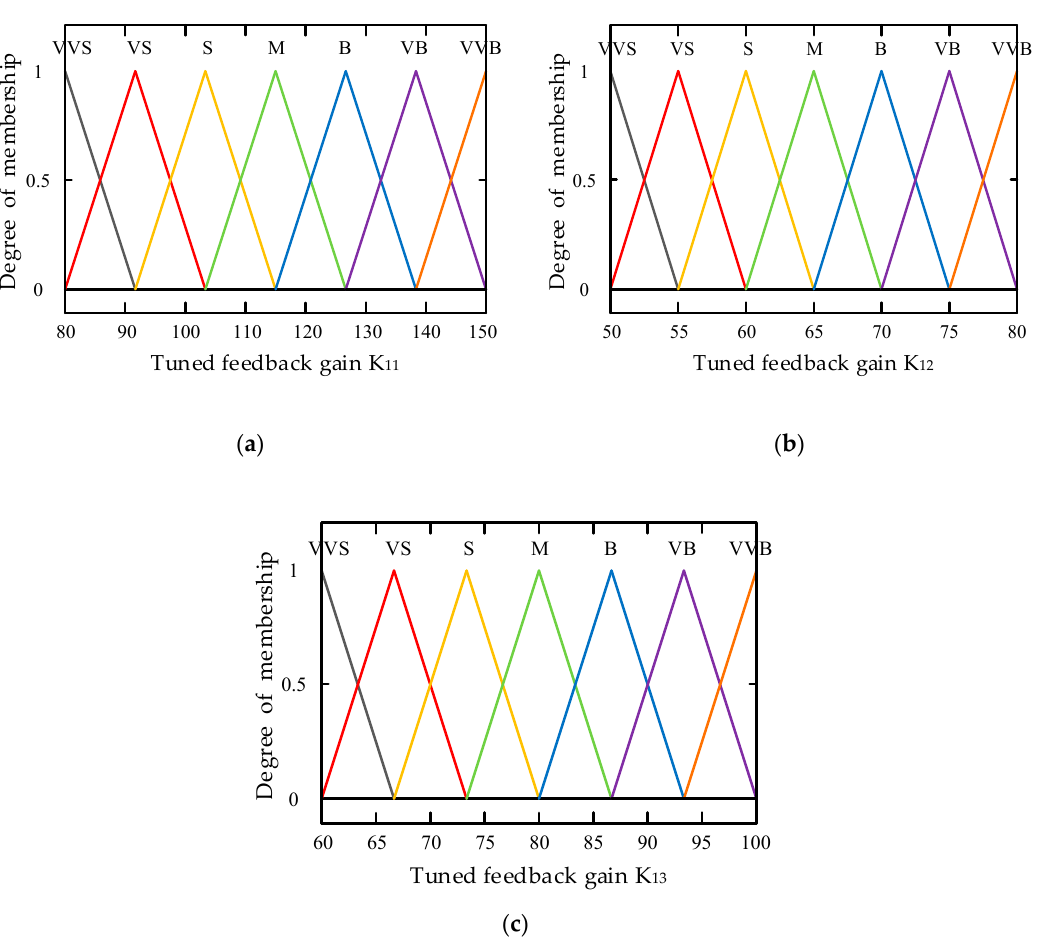
Figure 6. Membership function of the tuned feedback gains: ( a ) K i 1 , ( b ) K i 2 , ( c ) K i 3 .